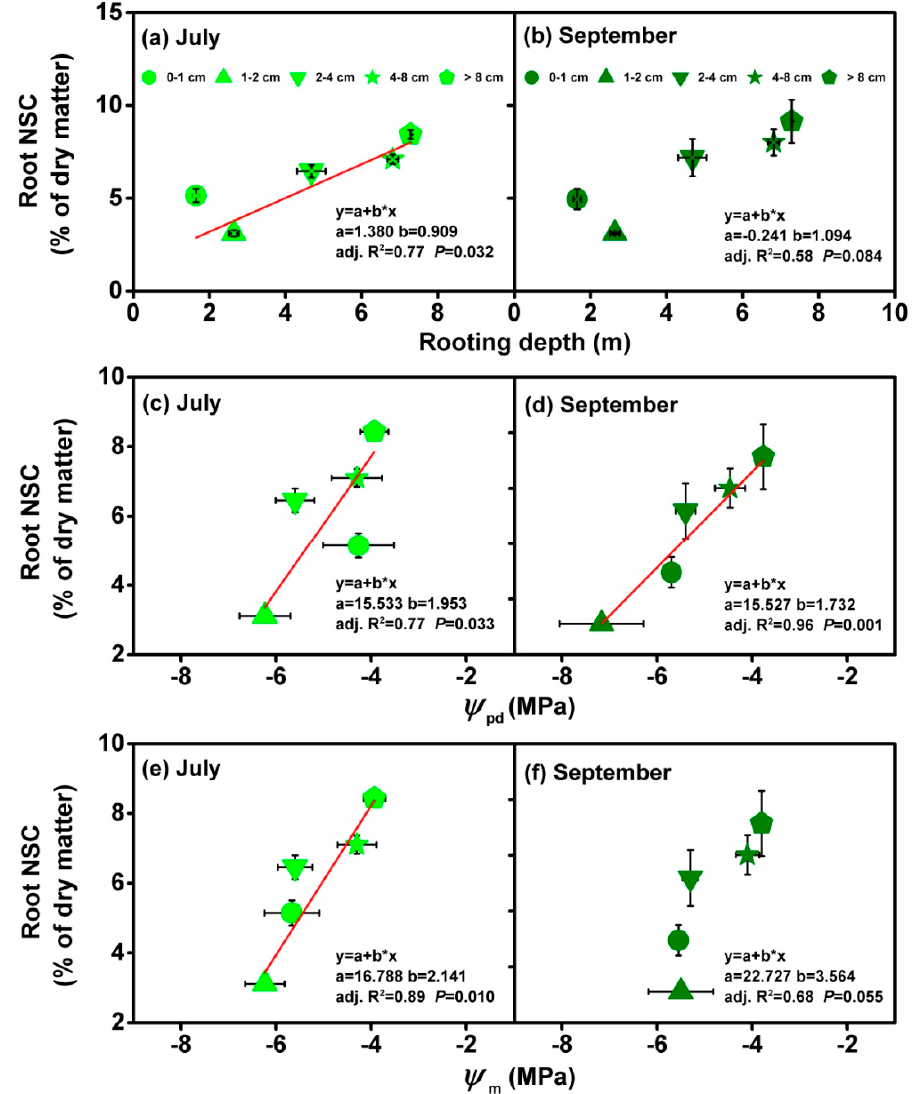
Figure 8. Percentage of dry matter in non-structural carbohydrates (NSC) of root drawn against rooting depth ( a , b ), predawn leaf water potential ( Ψ pd , c , d ) and midday leaf water potential ( Ψ m , e , f ) in mid-July of 2014 ( a , d , e ) and mid-September of 2014 ( b , d , f ). Data are mean ± 1SE ( n = 5).